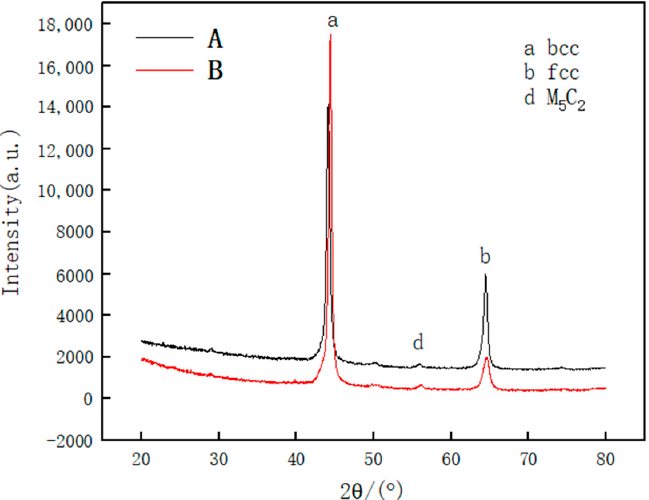
Figure 5. XRD spectra of cladding layers of Samples A and B.